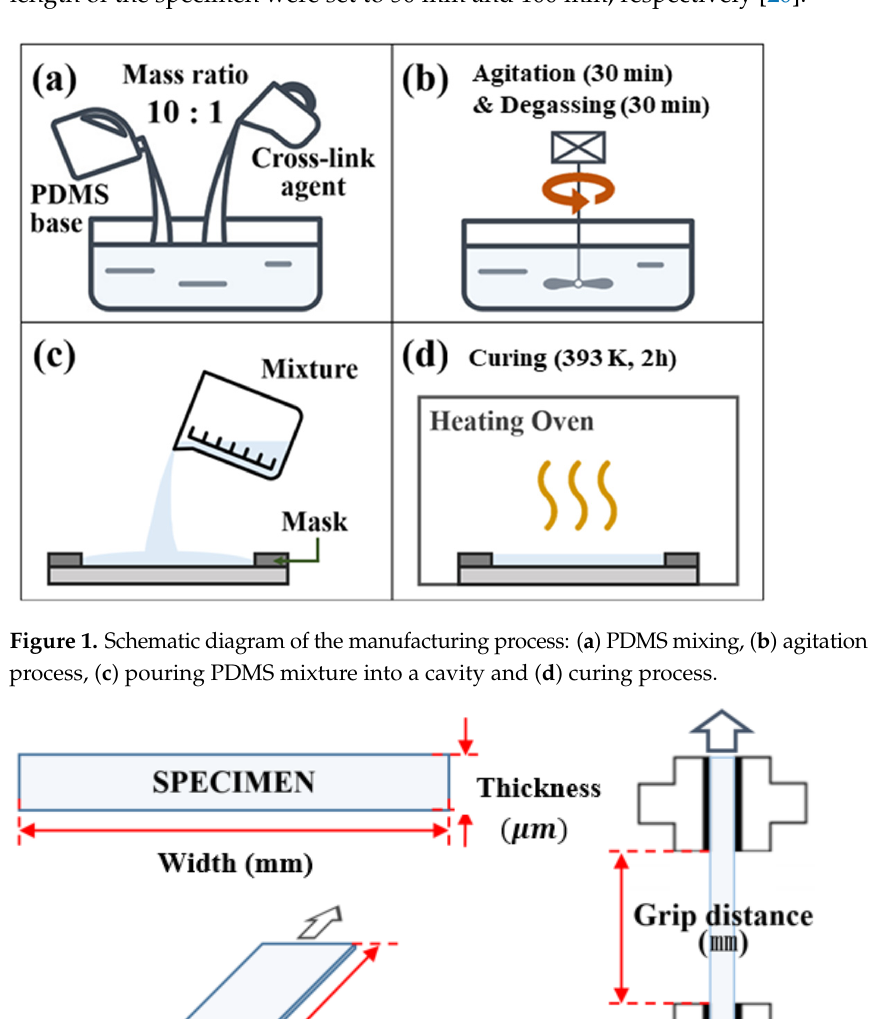
Figure 1. Schematic diagram of the manufacturing process: ( a ) PDMS mixing, ( b ) agitation & de- gassing process, ( c ) pouring PDMS mixture into a cavity and ( d ) curing process.